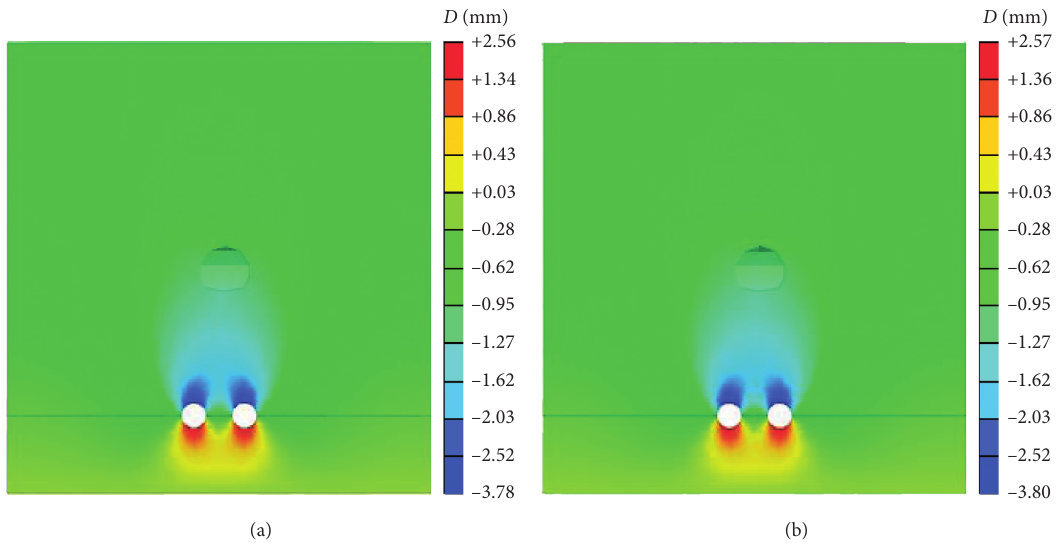
Figure 9: Cloud diagram of rock mass settlement of the newly built tunnel. (a) Excavation program I. (b) Excavation program II.